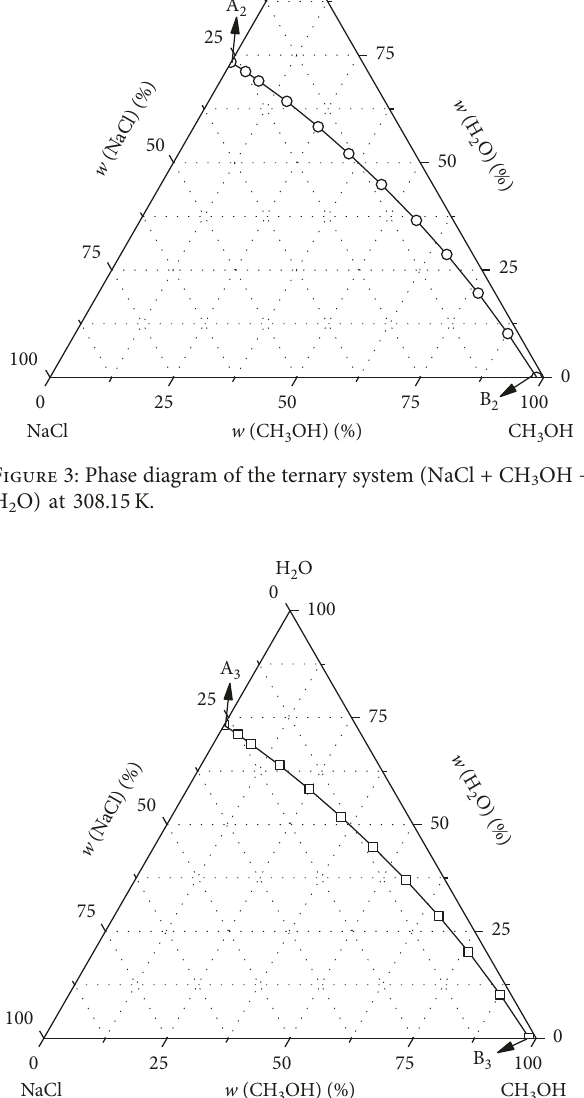
Figure 4: Phase diagram of the ternary system (NaCl + CH H 2 O) at 318.15K.